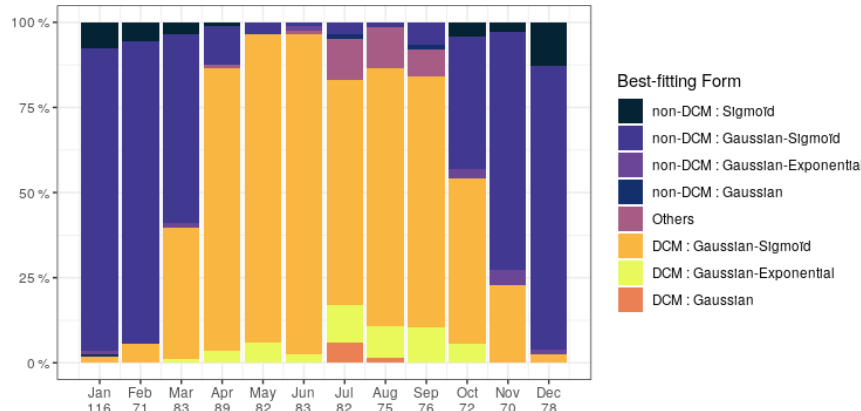
Figure 3. Percentage of best-fitting forms for chl a profiles for each month. Number of profiles is given on the horizontal axis.